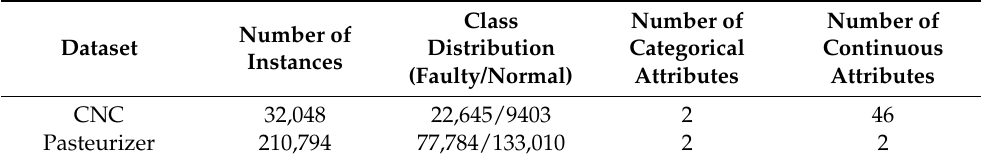
Table 2. Summary of two datasets (CNC and